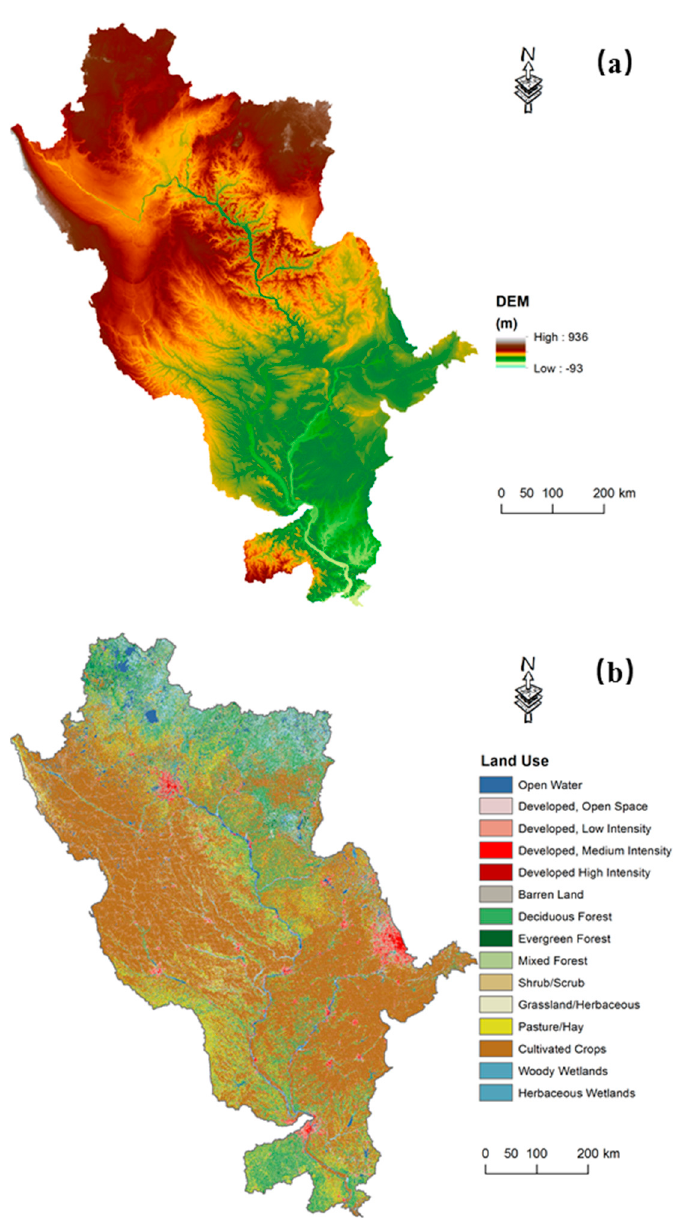
Figure 2. Digital elevation model (DEM) ( a ) and general land use ( b ) maps of the Upper Mississippi River Basin.